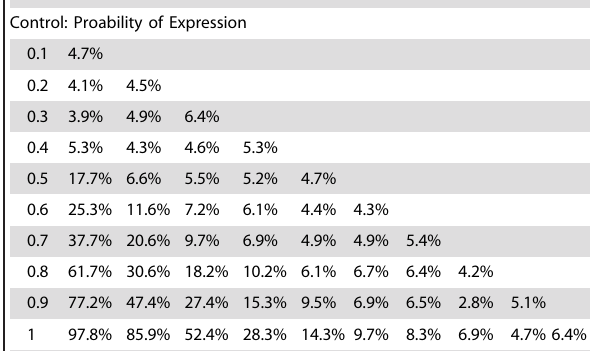
Simulation 4. Different mean expression intensities and